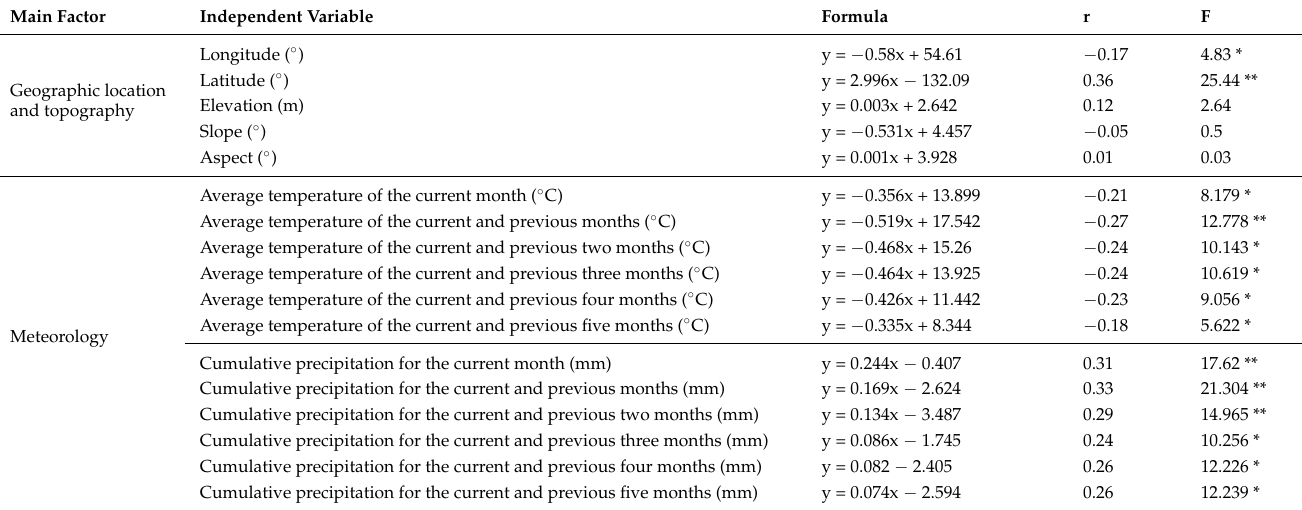
Table 4. Linear regression analysis of vegetation coverage based on a single factor (n = 171).